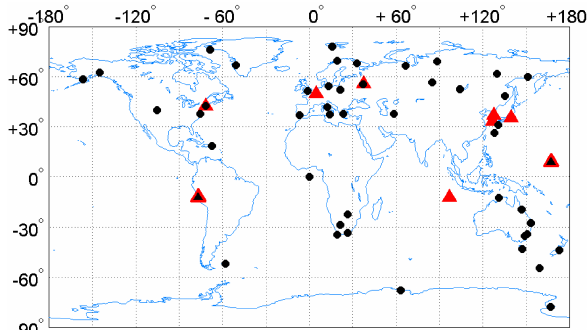
Figure 3. Ionosonde station positions. Black dots are ionosonde sta- tions used only for assimilation, red triangles are ionosonde stations used only for validation, and black triangles inside red triangles are ionosonde stations used for assimilation and